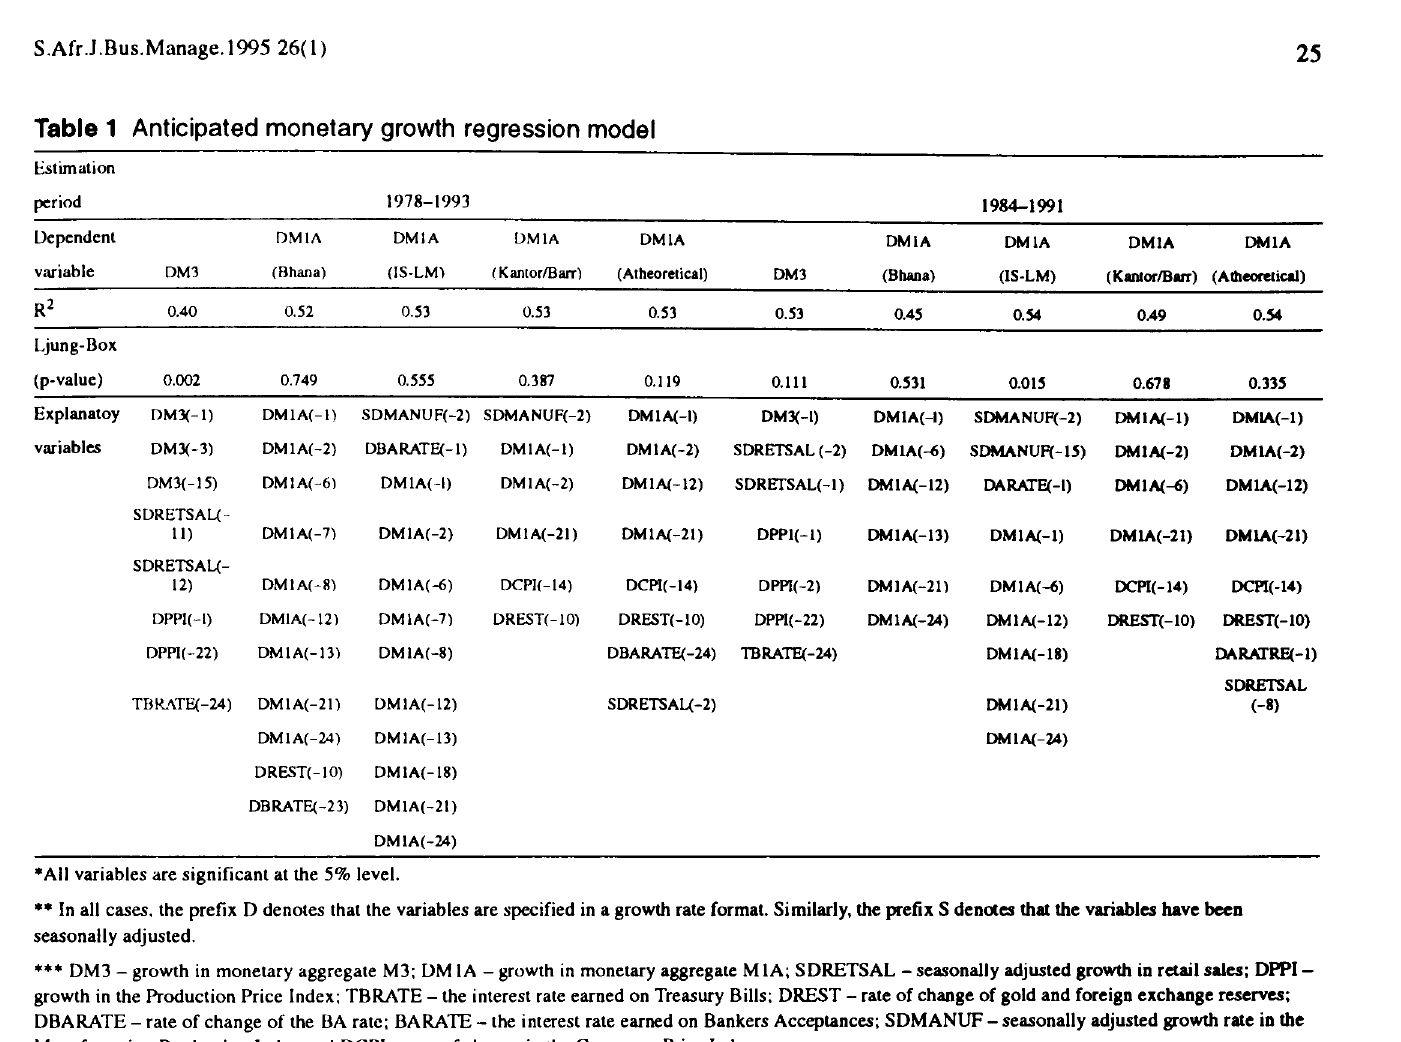
Table 1 Anticipated monetary growth regression